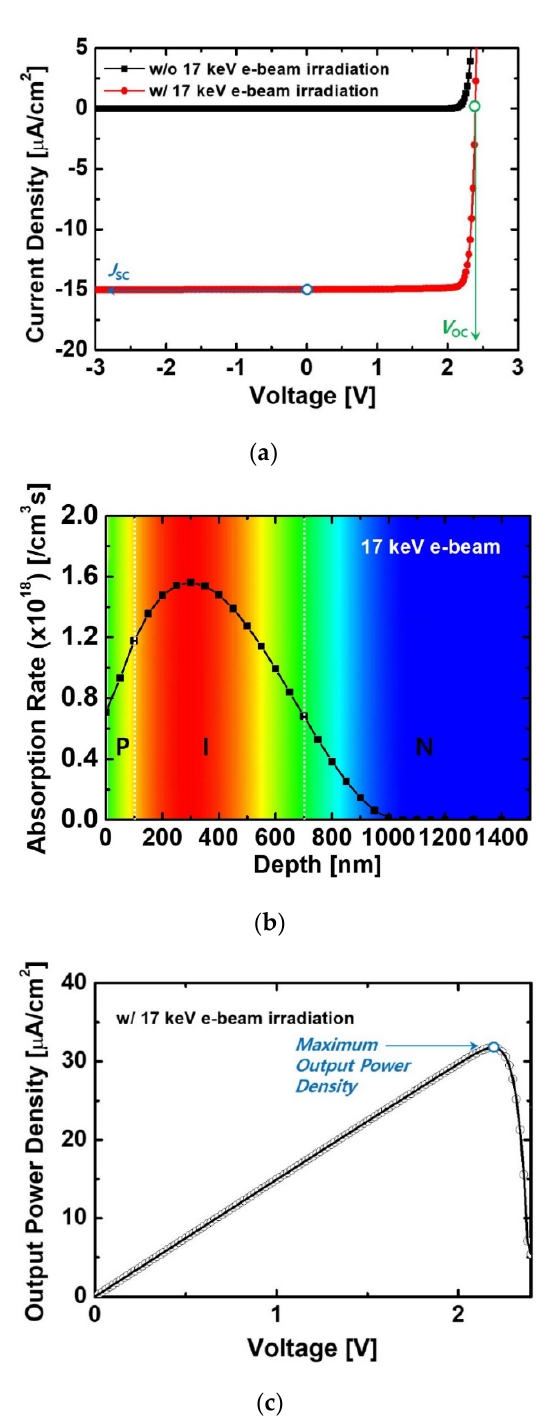
Figure 2. ( a ) Effects of e-beam irradiation on reverse current characteristics of the diode. ( b ) Absorption rate vs. penetration depth in the diode for 17 keV e-beam irradiation. ( c ) The output power density of the e-beam-irradiated diode. H p-GaN and H i-GaN in the diode were 100 nm and 600 nm, respectively. D p-GaN , D i-GaN , and D n-GaN were 5 × 10 17 cm − 3 , 1 × 10 16 cm − 3 , and 5 × 10 18 cm − 3 , respectively.